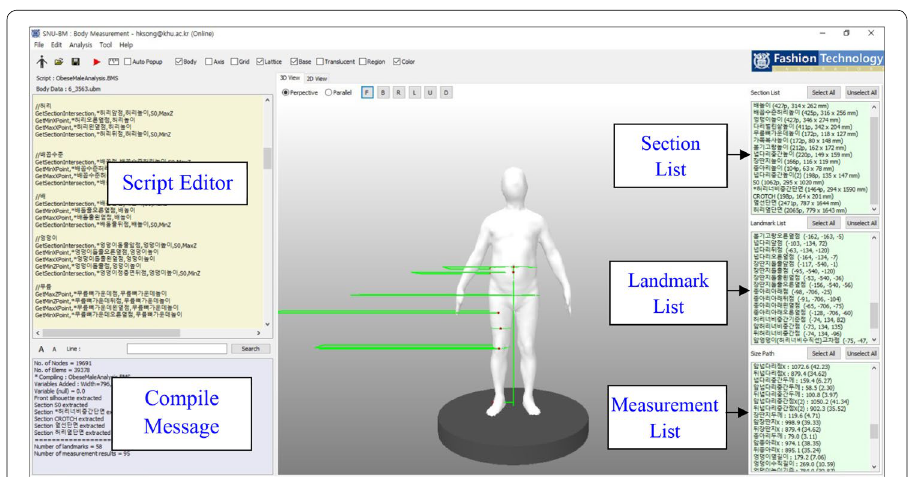
Fig. 3 Script-based automated 3D body scan measurements generated from SNU-BM